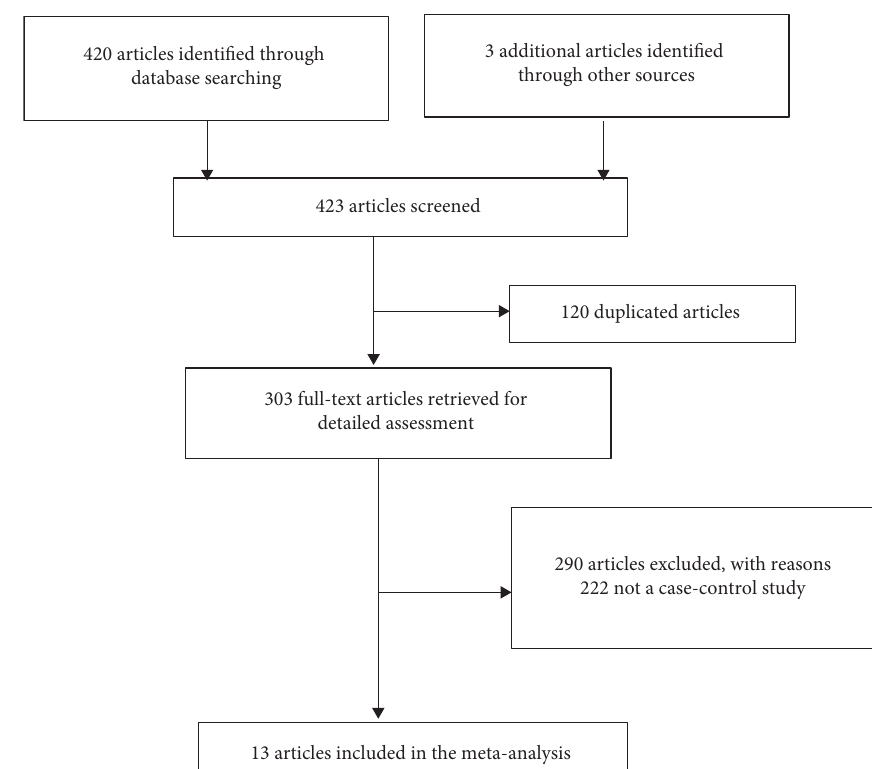
Figure 1: Flow diagram of the literature research.